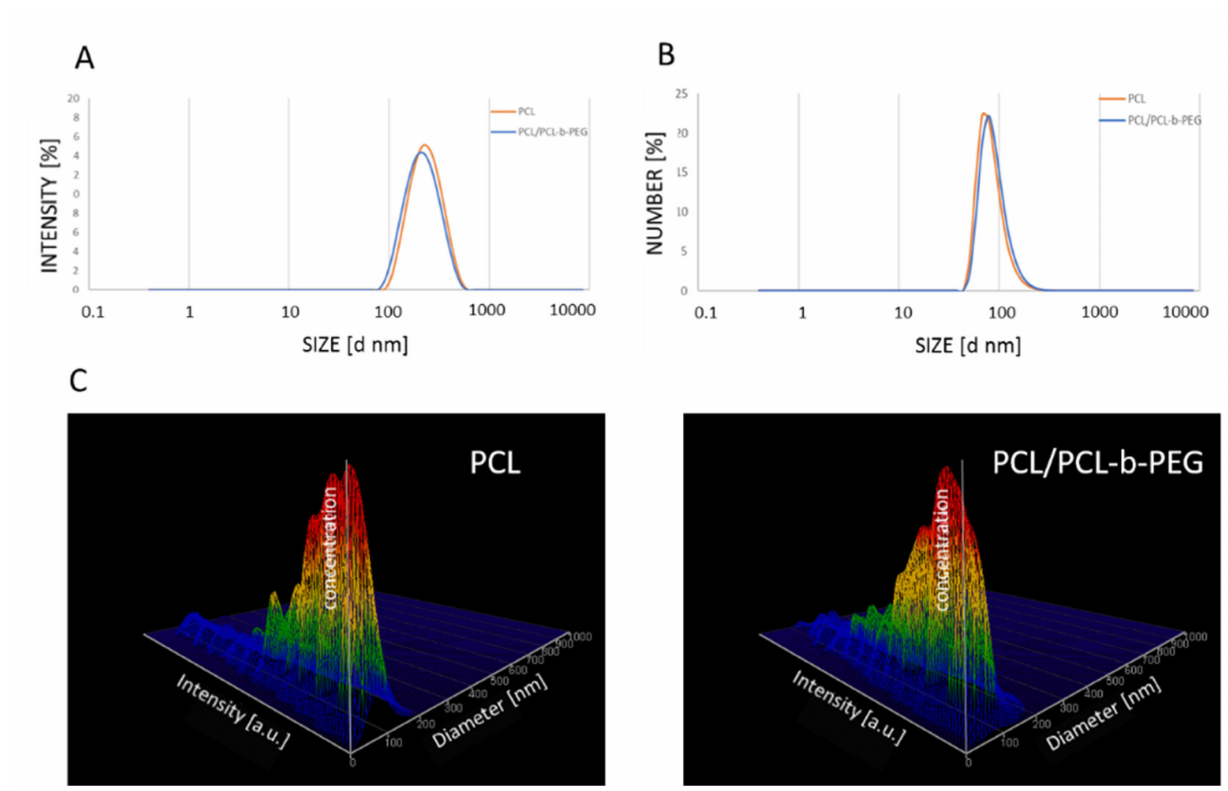
Figure 1. ( A ) Size distribution of nanoemulsion droplets containing PCL (orange) and PCL/PCL-b-PEG (blue), with an average size of ~250 nm. Size distribution of the synthesized PCL and PCL/PCL-b-PEG nanoparticles measured using the DLS ( B ) and NTA ( C ) techniques. Abbreviations: PCL (polycaprolactone), PEG (poly(ethylene glycol), DLS (dynamic light scattering), NTA (nanoparticle tracking